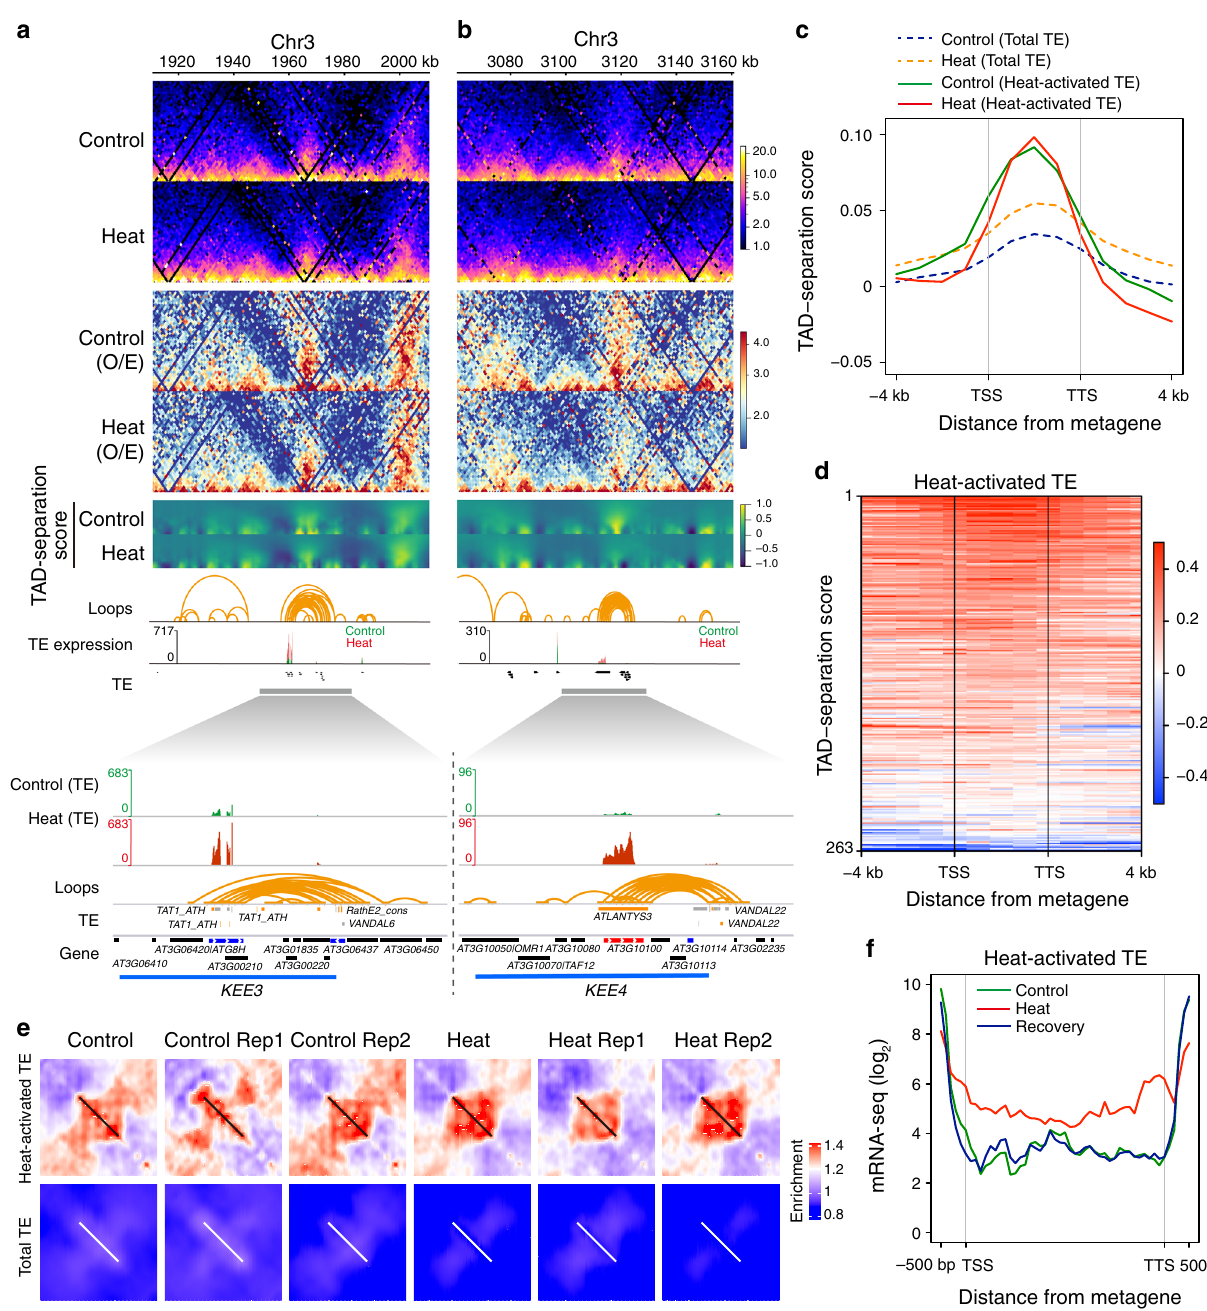
Fig. 6 Chromatin organization rearrangement revealed by high-resolution Hi-C correlates with heat-induced TE expression. a , b Changes of local chromatin organization and TE expression at KEE3 and KEE4 loci after heat treatment. Two 100 kb regions (depth: 50 kb) containing KEE3 and KEE4 , respectively, are shown. The top panels are heatmaps showing natural logarithm of 1 kb Knight and Ruiz (KR) normalized contact frequency in Control and Heat. Below are heatmaps (O/E) showing natural logarithm of observed/expected contact frequency in Control and Heat at 1 kb resolution. Below are heatmaps showing TAD-separation scores at different window sizes for each Hi-C genomic bin in Control and Heat. Loops were collected and transformed from a previous study ( “ Methods ” ). TE expression track shows the expression levels of TEs in Control and Heat. Their expression levels in Control and Heat are under the same scale and overlayered together. Only TE expression is shown. The expression of PCGs is not shown ( “ Methods ” ). The expanded panels show TE expression and the corresponding chromatin loops over KEE3 and KEE4 . c Metagene plot of TAD-separation scores over bodies of heat- activated TEs and total TEs and fl anking regions. Only TEs with length over 1,000 bp are considered. TSS transcription start site, TTS transcription termination site. d Heatmap of TAD-separation scores over bodies of 263 heat-activated TEs and fl anking regions in Control. e Local rescaled pileup of chromatin organization over bodies of heat-activated TEs (upper panel) and total TEs (lower panel) in Control, Heat, and different biological replicates. The values are normalized by a local background ( “ Methods ” ). The diagonal bars are the locations of scaled heat-activated TEs (upper panel) and total TEs (lower panel). f Metagene plot of RNA-Seq read coverage over bodies of heat-activated TEs in Control, Heat, and Recovery. Heat stress can activate heterochromatin-associated transposon elements (TEs). Here, the authors show that heat stress leads to global rearrangement of 3D genome and TEs activation closely correlates with 3D chromatin organization rearrangement in Arabidopsis